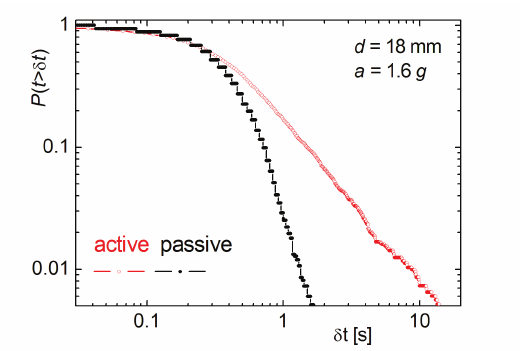
Figure 4. Cumulative distribution of delay times δt be- tween subsequent individual particles passing the outlet.